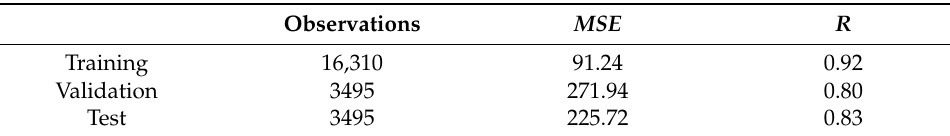
Table 10. ANN regression statistics and MSE .